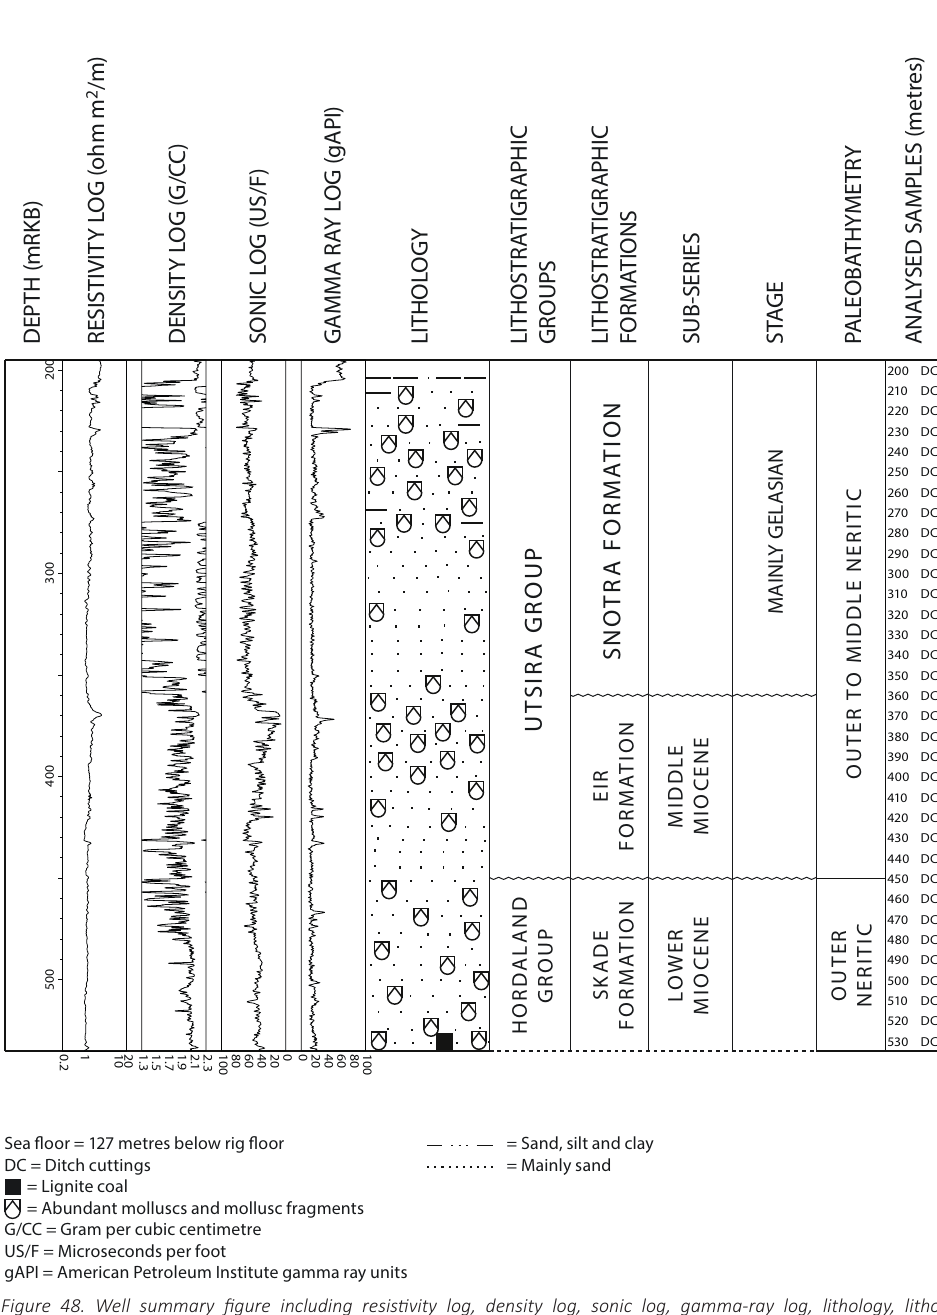
= Sand, silt and clay = Mainly sand